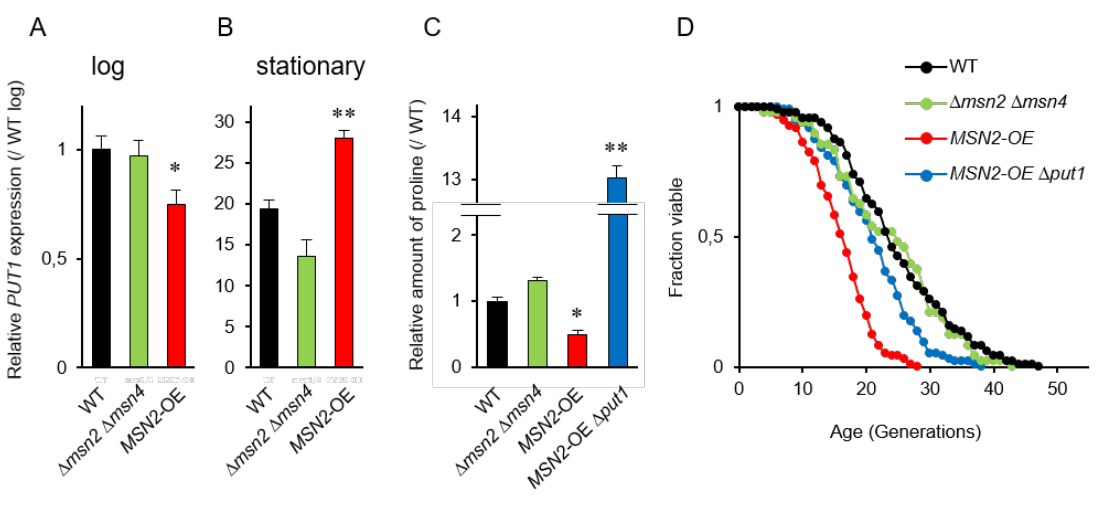
FIGURE 2: The stress-responsive transcription activator genes MSN2/MSN4 are involved in replicative lifespan. (A and B) The expression of PUT1 in Δ msn2 Δ msn4 double deletion strain and MSN2 -overexpressing strain at log and stationary phases compared with that in the wild-type strain (WT; BY4741) at log phase. The values are the means and standard deviation of results from three independent experi- ments. *, p < 0.05; **, p < 0.01, versus WT calculated with the Student’s t -test. (C) Intracellular proline levels in the indicated strains com- pared with WT at stationary phase. The values are the means and standard deviation of results from three independent experiments. *, p < 0.05; **, p < 0.01, versus WT calculated with the Dunnett’s test. (D) Replicative lifespan of the indicated strains . The data for WT was the same as Figure 1A and 1D. The results of other mutants, which were analyzed independently, and WT were